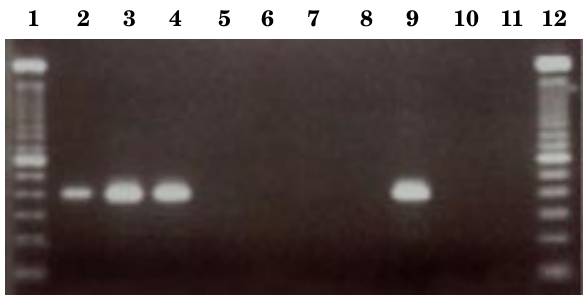
Fig. 3. Amplicons of direct polymerase chain reaction using the primer-pair Dest1 and Dest4 for Cylindrocar- pon destructans , using DNA extracted from C. de- structans isolates supplemented with healthy grapevine tissues, and from artificially infected grapevine plants. Lanes: 1 and 12, molecular weight markers (100 bp; GIBCO-BRL, Life Technologies); 2–4, extracts from healthy grapevines plus Cy7, Cy24 and Cy30 cultures respectively; 5–8 extracts from artificially infected grapevine plants with Cy2, Cy7, Cy30 and Cy68 isolates respectively; 9, positive control (Cy1); 10 and 11, nega- tive controls (extracts from healthy grapevines and wa- ter respectively).